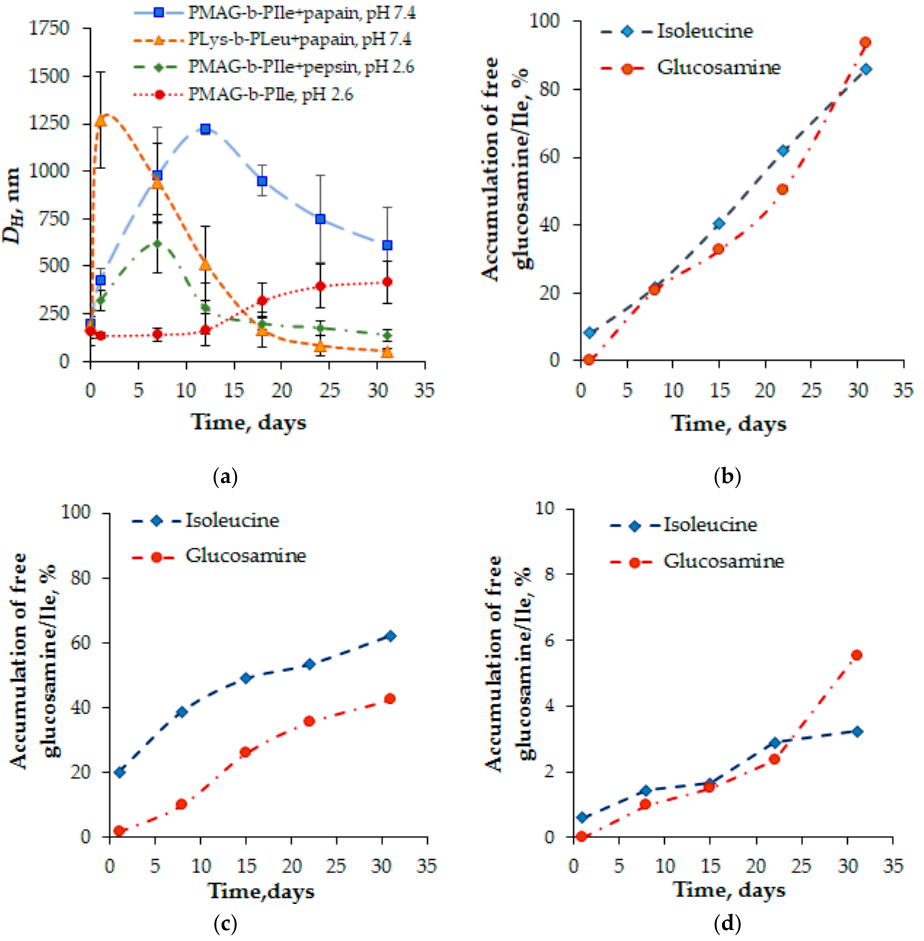
Figure 9. Monitoring of the biodegradation process of (PMAG- b -Ile)-based particles (sample b7 ) at 37 °C in different media: ( a ) changes in hydrodynamic diameters of PMAG- b -Ile and PLys- b -PLeu NPs (DLS); ( b – d ) accumulation of free isoleucine and glucosamine (HPLC) in: 0.02 M Clark-Labs buffer, pH 2.6, containing pepsin ( b ); 0.01 PBS, pH 7.4, containing papain ( c ), and human blood plasma ( d ).